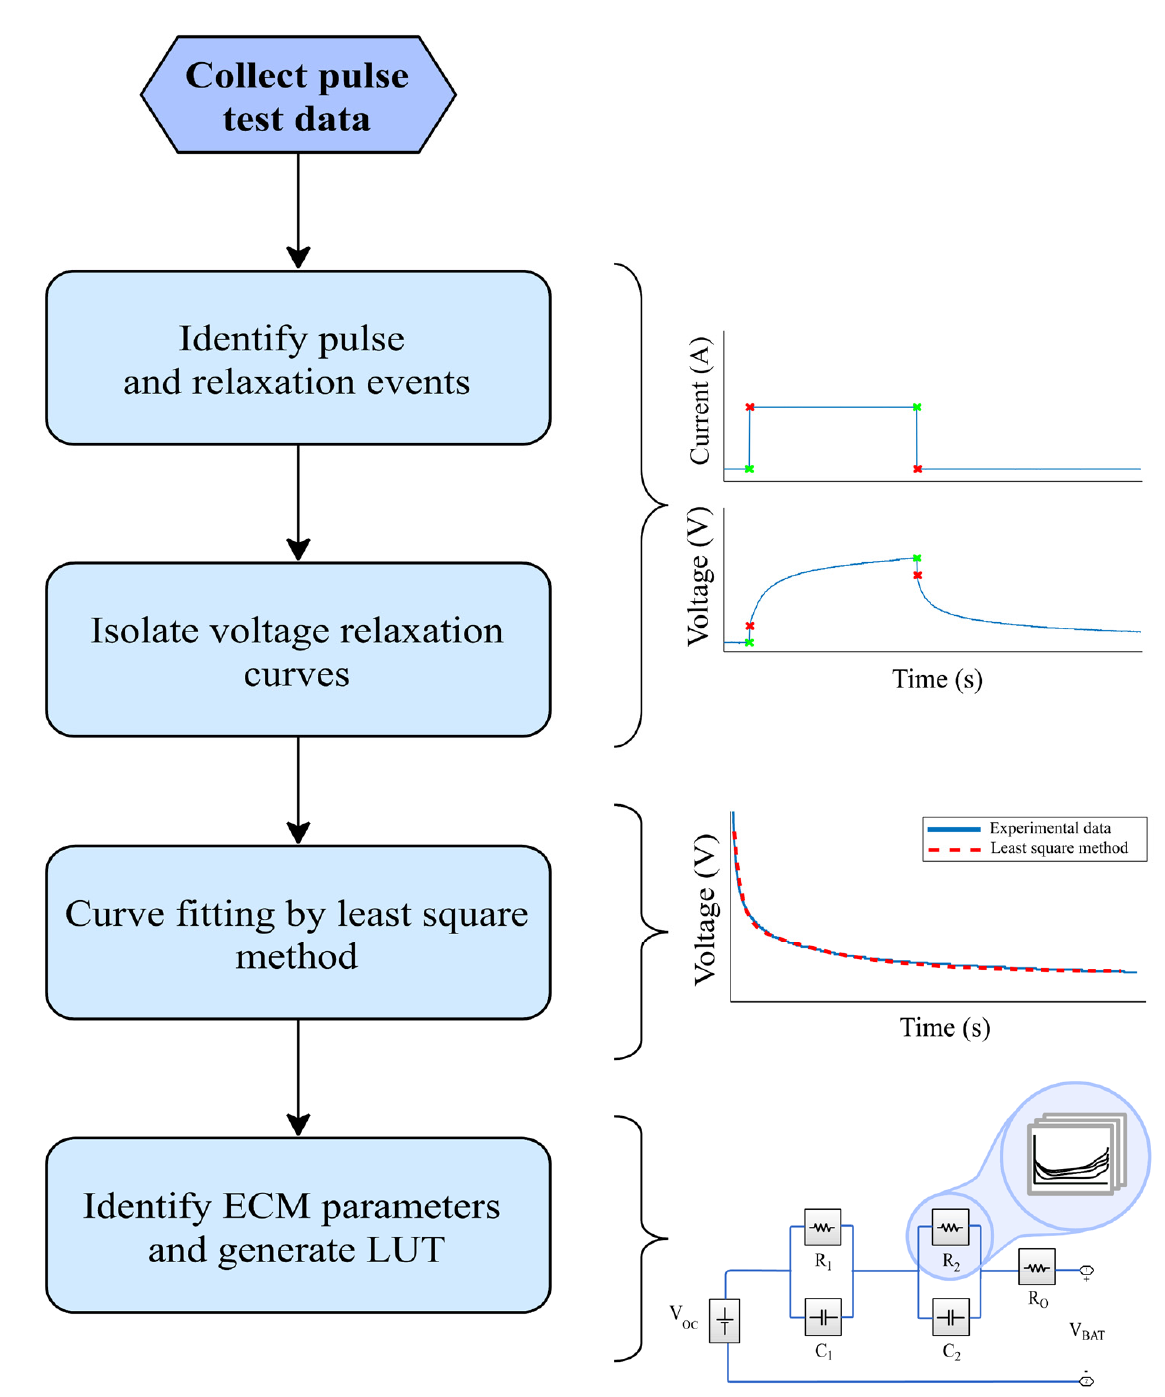
Figure 7. Followed procedure in the ECM parameter identification code.